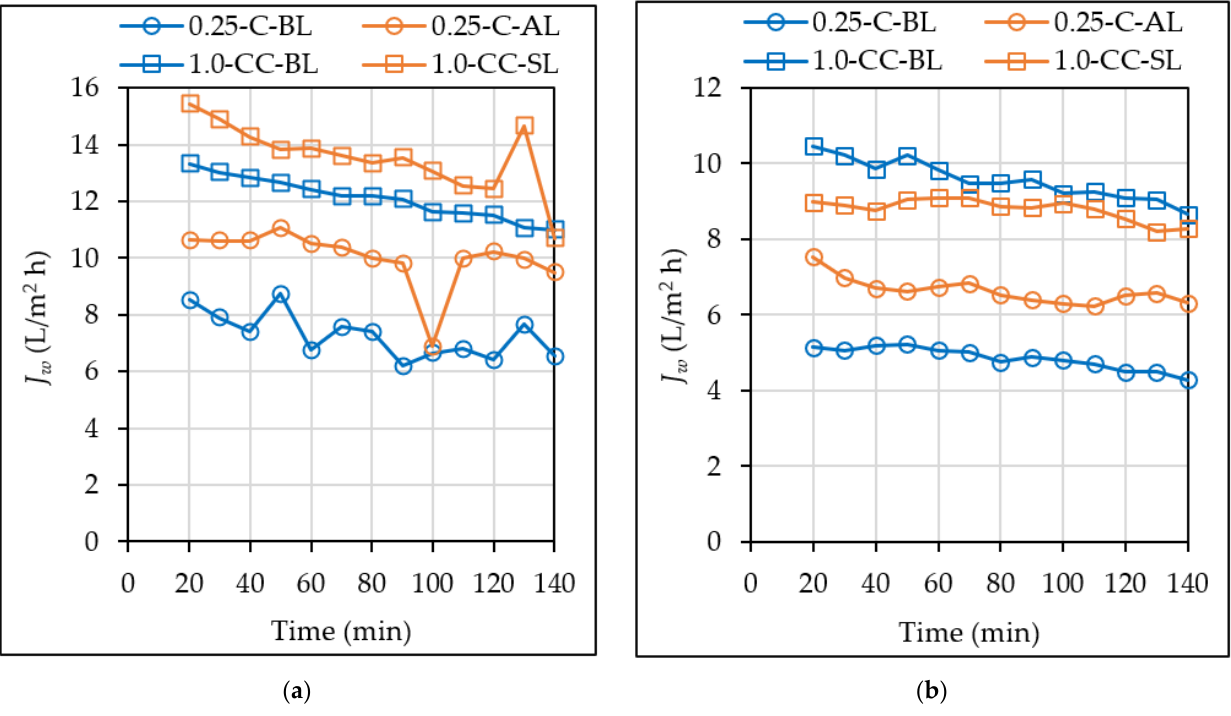
Figure 2. Changes in flux with time for runs of the tested cases with ( a ) NaCl and ( b ) MgCl 2 draw Scheme 0. C-BL and 1.0-CC-BL) and with the ultrasound facing the active layer (0.25-C-AL) or facing the support layer (1.0-CC-SL) of the membrane. In naming the baseline cases (i.e., without ultra- sound), C denotes co-current flow, CC denotes counter-current flow, and BL denotes baseline con- ditions.